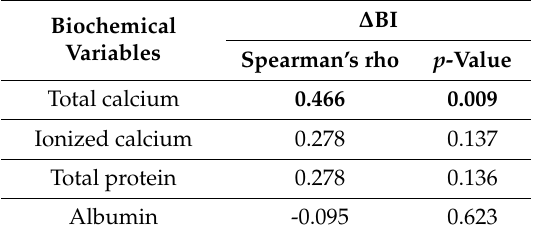
Table 2. Correlation between biochemical variables and changes in performance in activities of daily living, as measured by the changes of the Barthel Index ( ∆ BI). Values in bold indicate a p -value lower than 0.05.